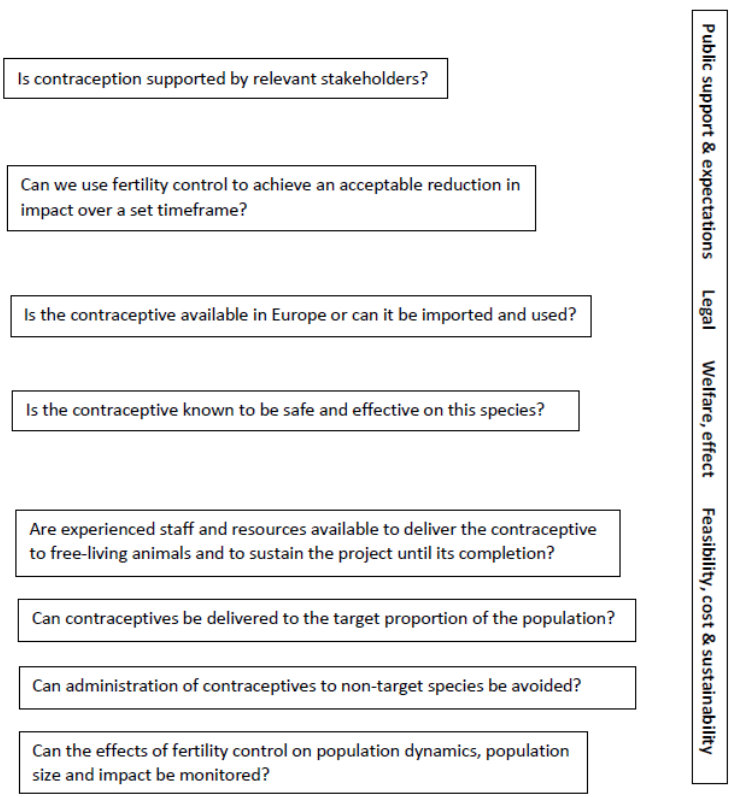
Figure 1. A framework to guide decisions about the use of fertility control to mitigate wildlife impacts. Illustrated are questions that should be considered before implementing a fertility control plan for free-living wildlife. If the answer to all the questions is “yes”, the plan provides a framework for assessing whether fertility control will be likely to meets the stated goals. If the answer to any question is “no”, fertility control should not be implemented until the issue has been resolved.